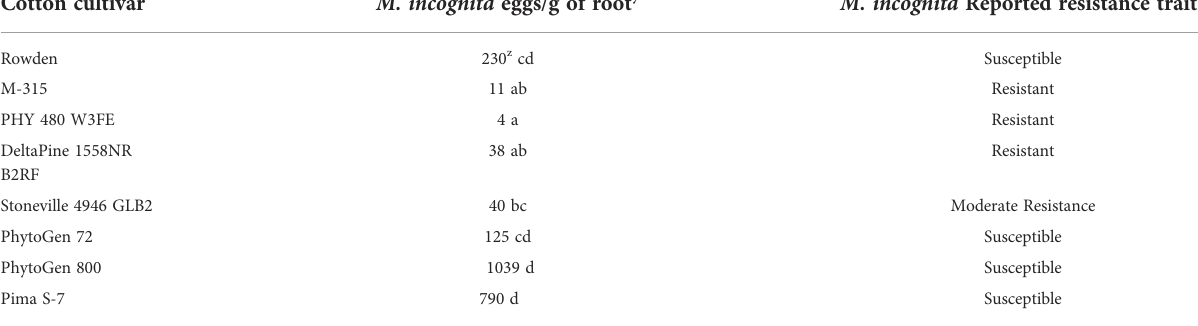
TABLE 3 Meloidogyne incognita race 3 average root population density by cotton cultivar from all Fusarium testing during 2018 and 2019 in the National Cotton Fusarium Wilt Evaluation fi eld. Cotton cultivar